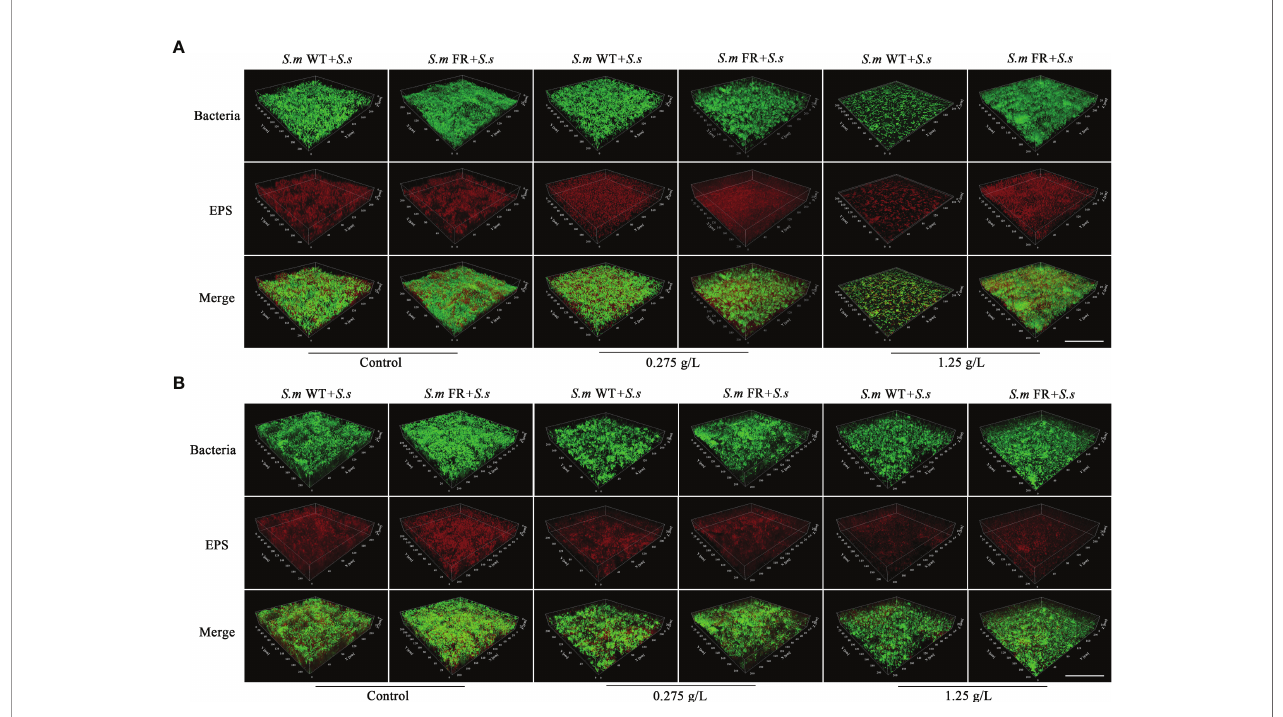
FIGURE 5 | Representative confocal images of EPS staining in different NaF concentrations. (A) Dual-species bio fi lm formation. (B) Pre-formed dual-species bio fi lms. Total bacterial cells were labeled with SYTO 9 (green) and exopolysaccharide with Alexa Fluor 647 (red). Size marker equals 100 m